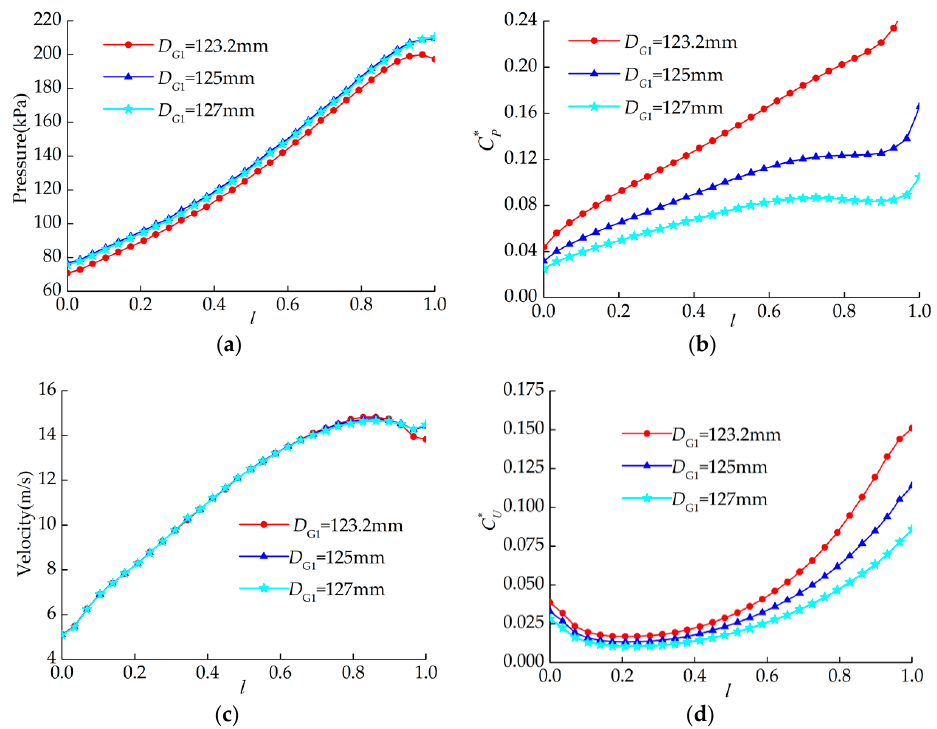
Figure 22. The time-average and the fluctuation intensity curves of pressure and velocity on the blade